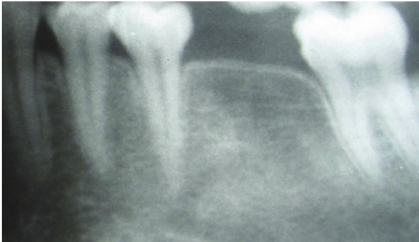
Figure 2: Preoperative radiograph of tooth, number 36, note the good height of the alveolar bone.